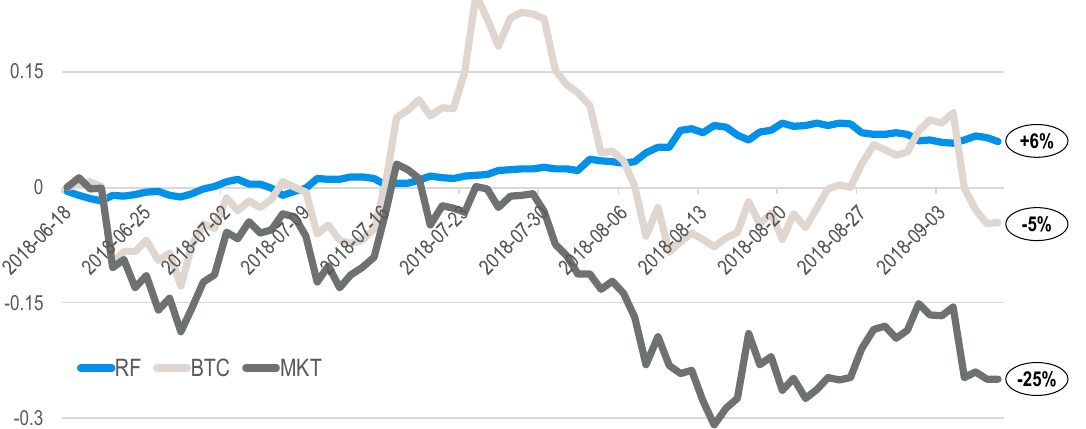
Figure 1. Development of financial performance of random forest model (RF) when investing in the top-3 and flop-3 coins vs. Bitcoin (BTC) and general market (MKT), i.e., an equal investment in all coins at the beginning of the trading